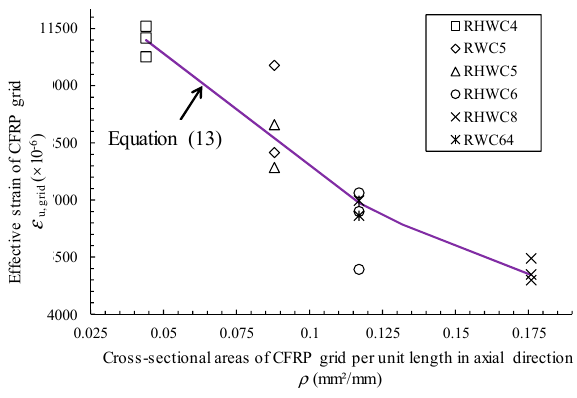
ff ective strain of vertical CFRP grid. Figure 12. Effective strain of vertical CFRP grid. Figure 12. Effective strain of vertical CFRP grid. Figure 12. E